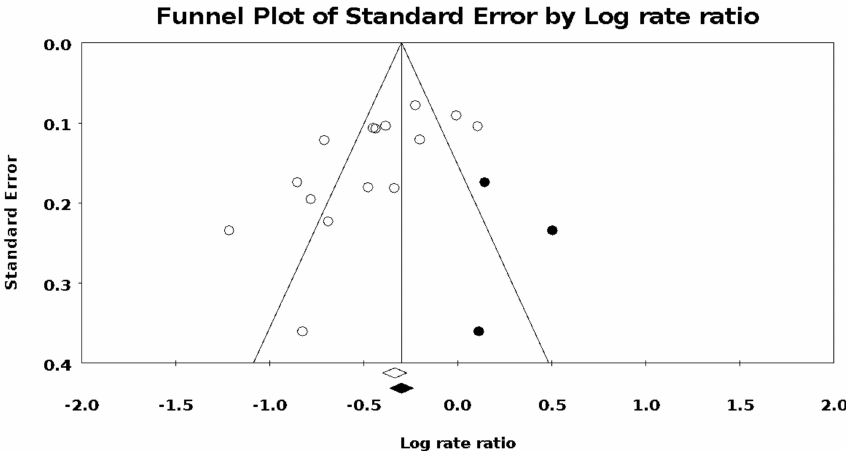
Figure 2. Funnel plot based on study standard error and log risk ratio in assessing publication